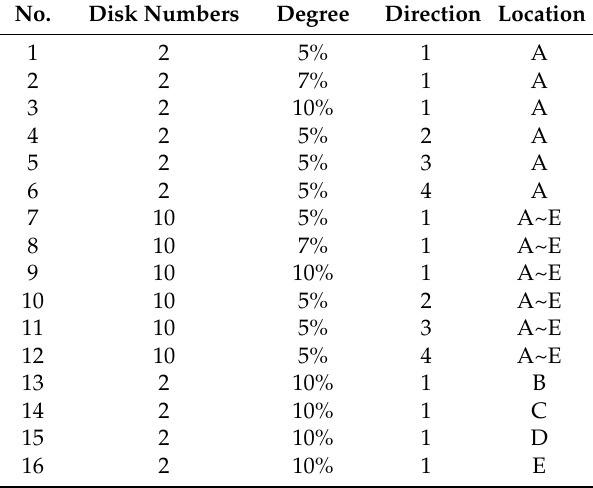
Table 2. Setup of RD fault in middle 10-disk windings.